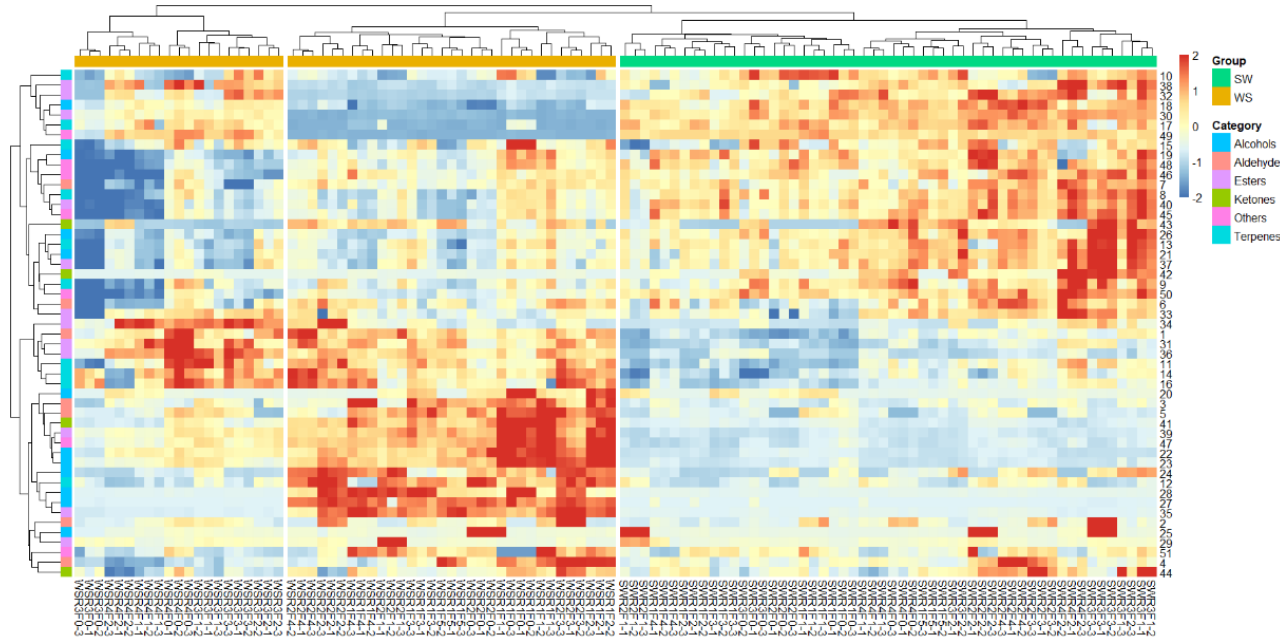
Figure 2. Clustering heat map of volatile compounds in black teas processed by withering-shaking and shaking-withering. The numbers in the row names of the heat map represent compounds, and the correspondence between numbers and compounds is shown in Table S1 of the Supplementary Materials.